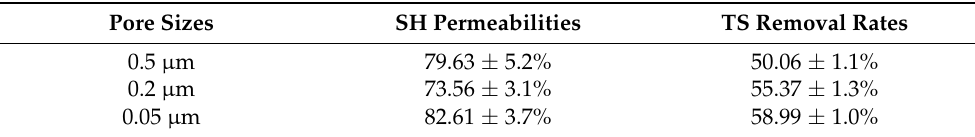
Table 2. SH permeabilities and TS removal rates ( n = 3).